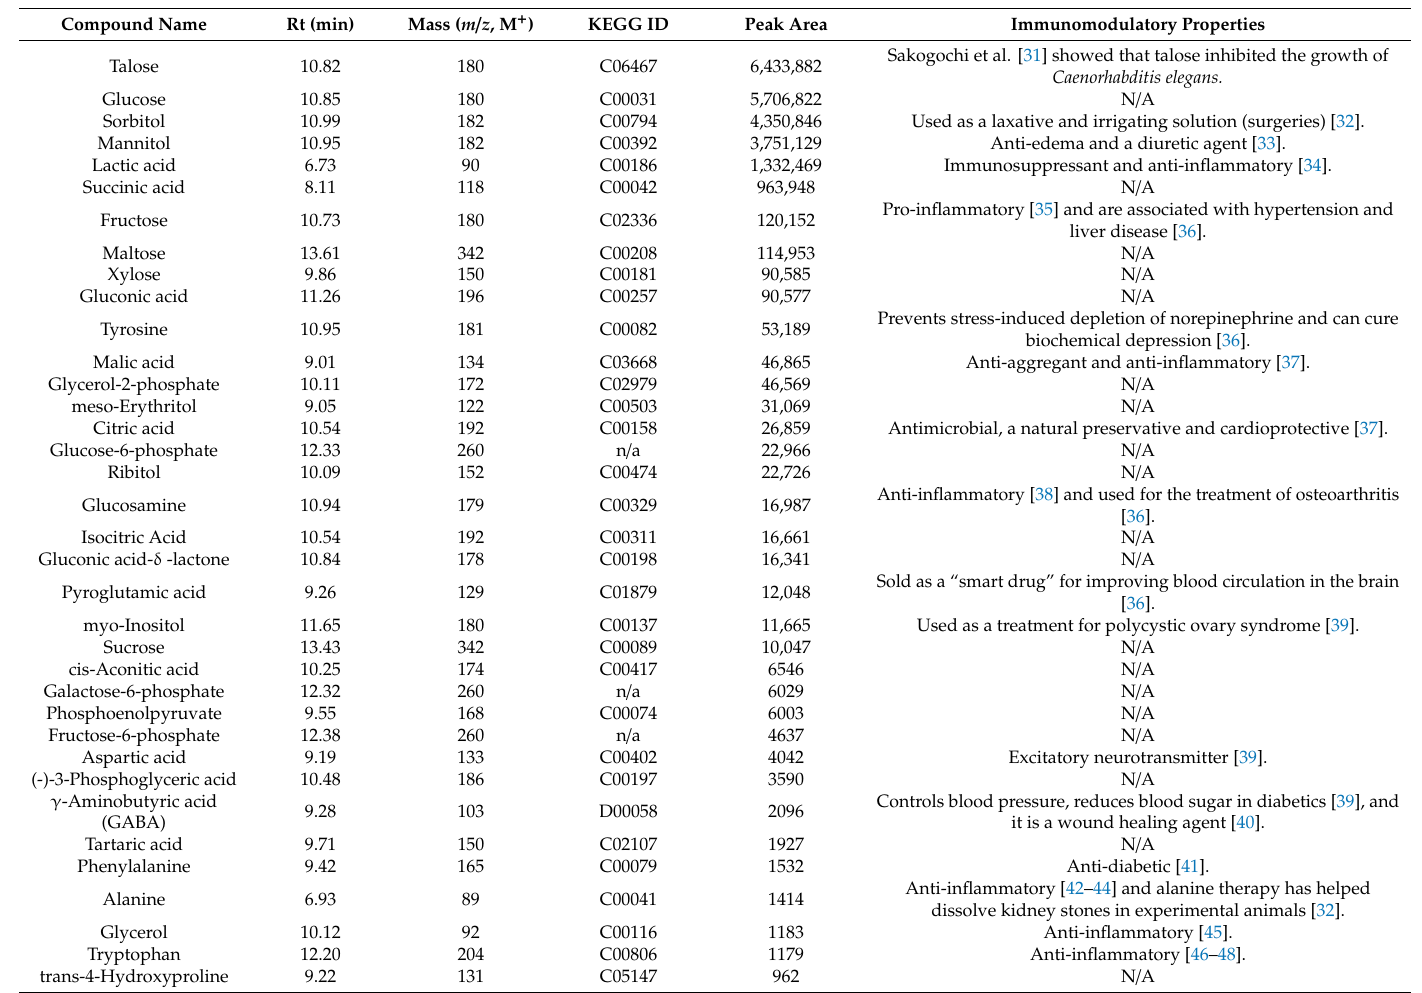
Table 1. Polar metabolites identified from the ESPs of T. canis using GC-MS (the peak area of each T. canis ESP metabolite was subtracted from the peak area of media